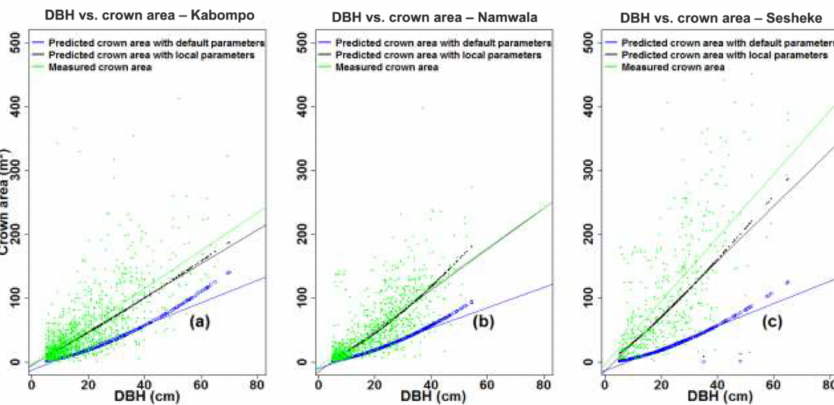
Figure 5. Measured and predicted crown area plotted against DBH at Kabompo (a) , Namwala (b) , and Sesheke (c)